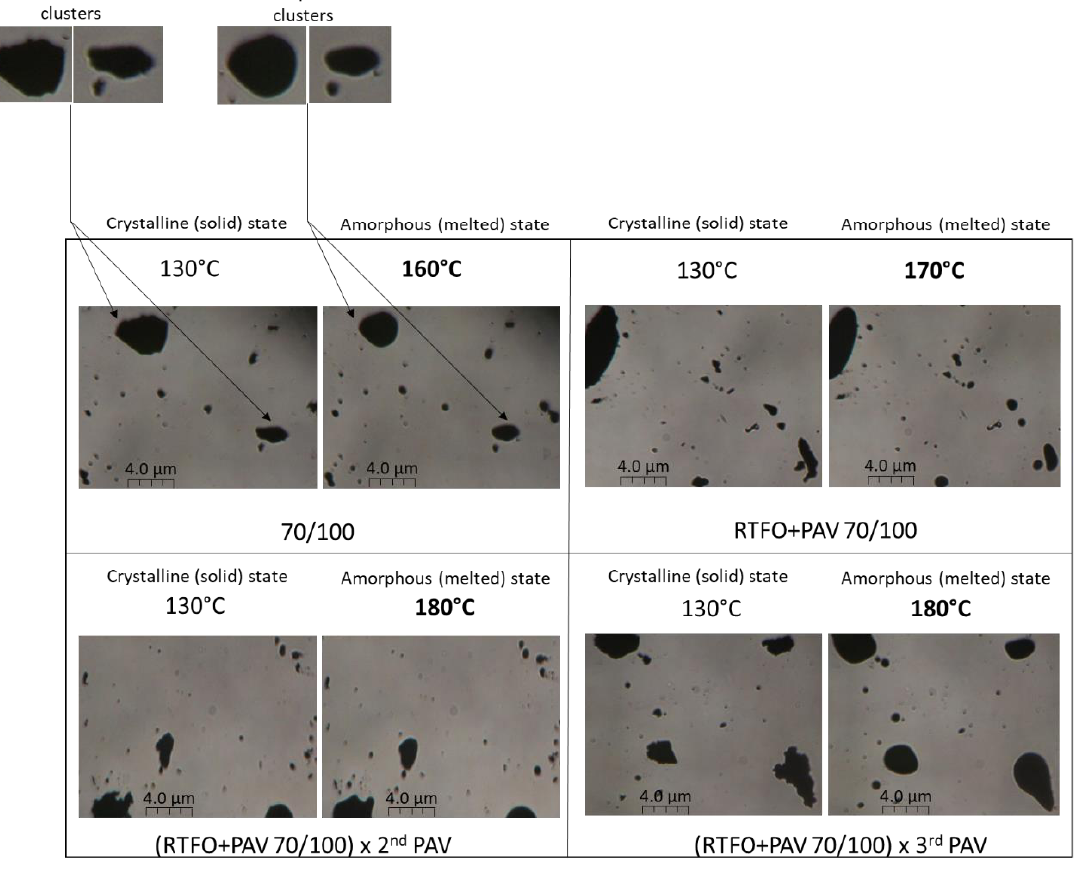
Figure 5. Light microscopy images indicating asphaltene melting points of virgin and aged 70/100 bitumen.